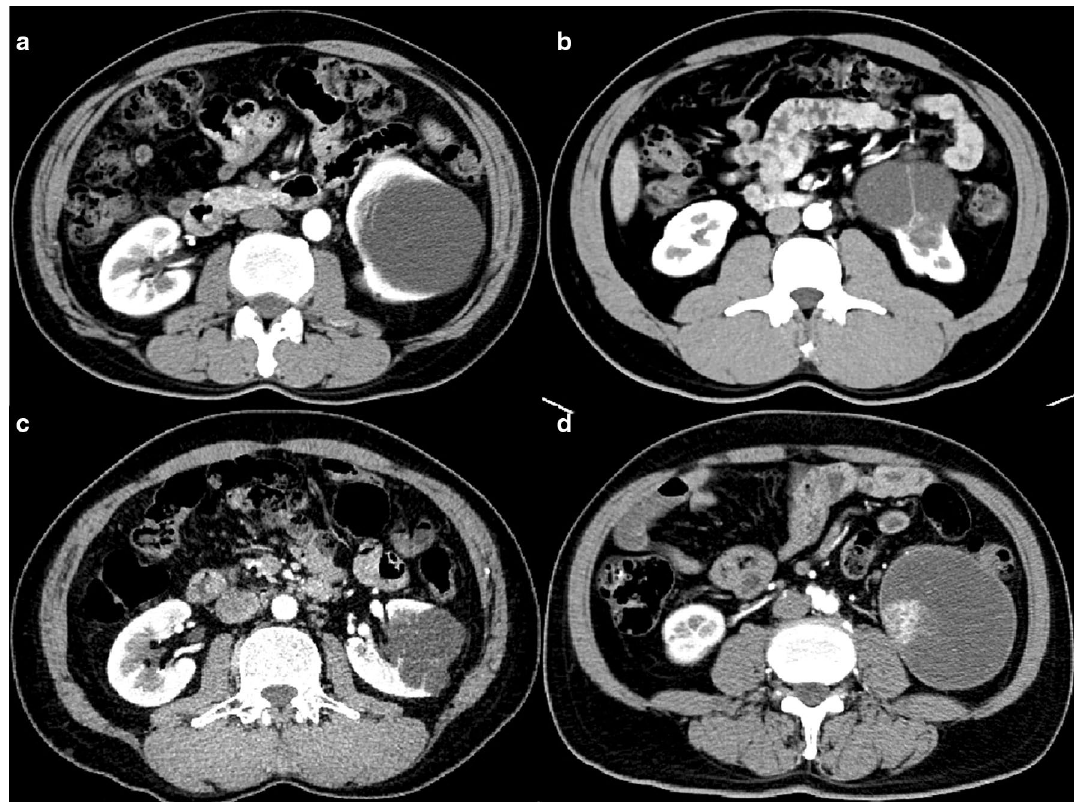
Fig. 7 Arterial phase images for four cystic renal lesions in the external validation datasets. CRL in a is benign 2019 Bosniak II lesion and Bosniak IIF CRL in b is identified as multilocular cystic renal neoplasm of low malignant potential according to the histopathologic results after surgery. Cystic renal lesion in c, d were classified as 2019 Bosniak IIF CRL (benign pathology) and IV CRL (malignant pathology) respectively. Blending